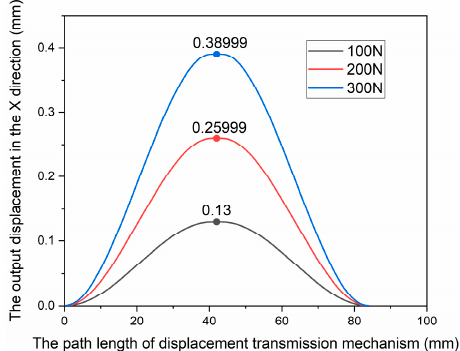
Figure 8. Relationship between force and displacement curve of micro-platform in the X direction.